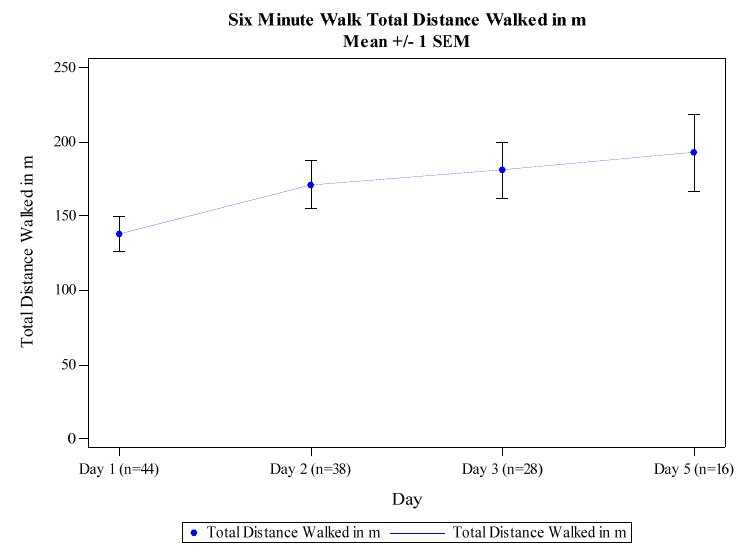
Figure 3. 6MWT distance (meters) from day 1 through the end of Day 5. Only 16 subjects were still hospitalized at Day 5.